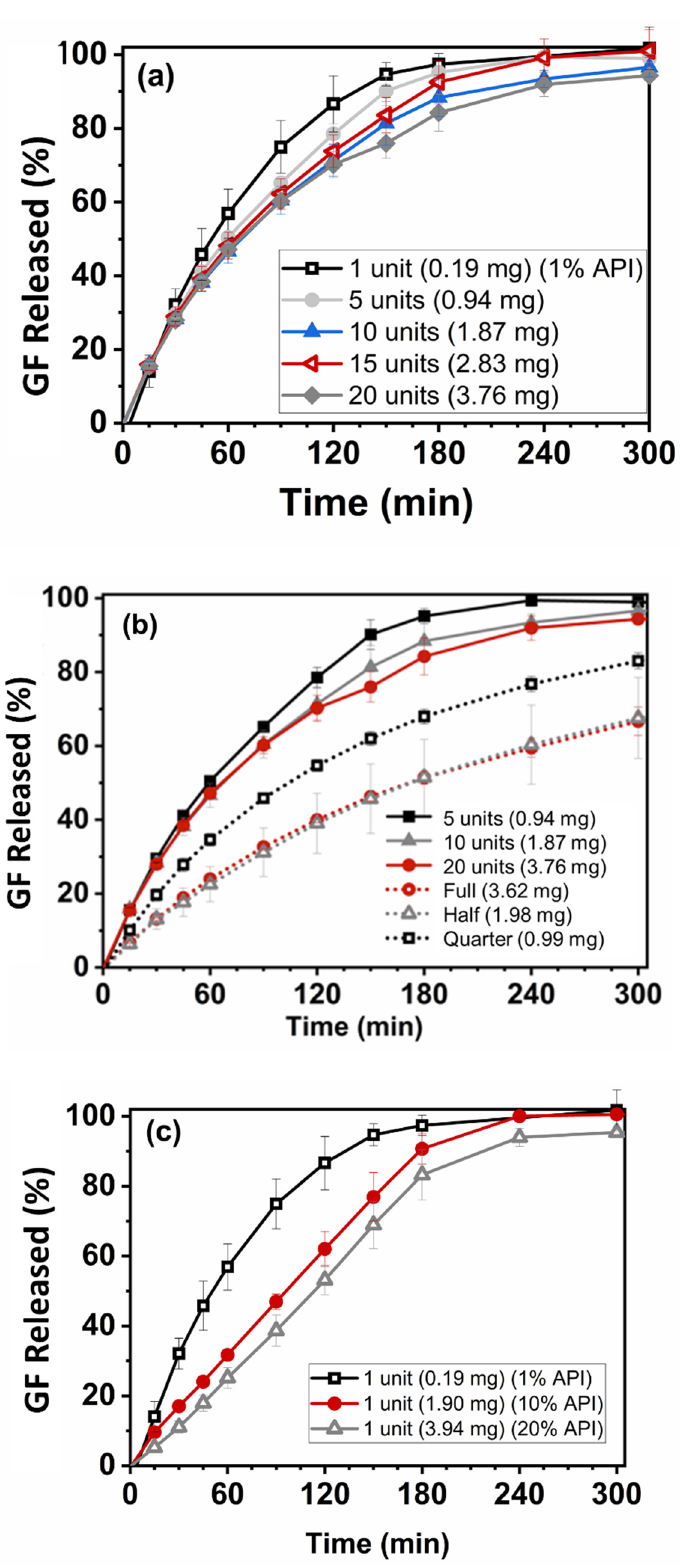
Figure 5. Drug release profiles of ( a ) single unit and multi units mini-tablet(s) at 1.0 wt% drug concentration, ( b ) split tablets at 1.0 wt% drug concentration, and ( c ) single unit mini-tablets at 1.0–20.0 wt% drug concentrations.